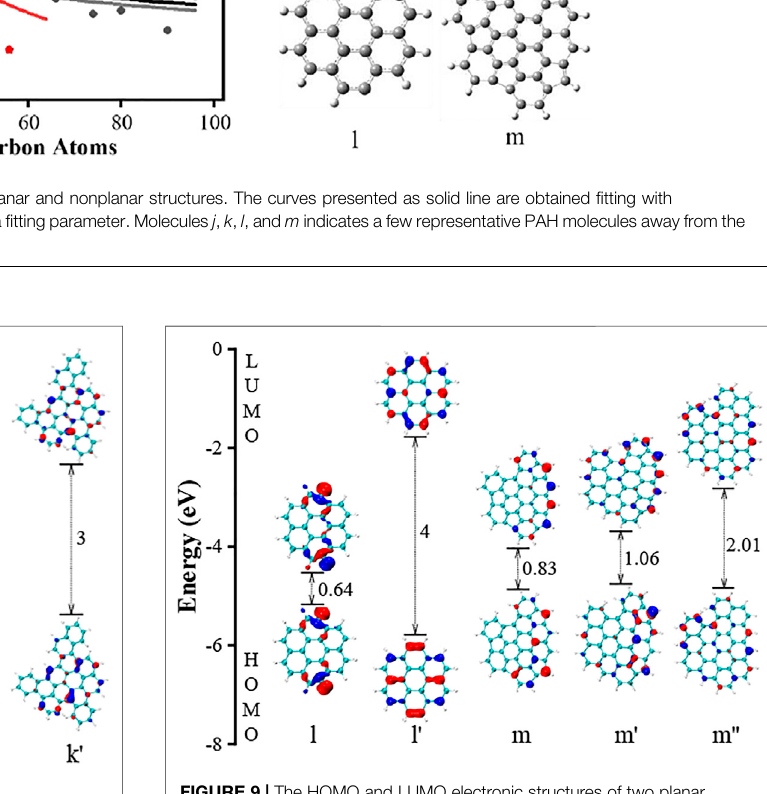
FIGURE 8 | The HOMO and LUMO electronic structures of selected nonplanar j and k . The j ’ and k ’ is made from replacing fi ve-member rings in j and k by six-member rings, respectively.